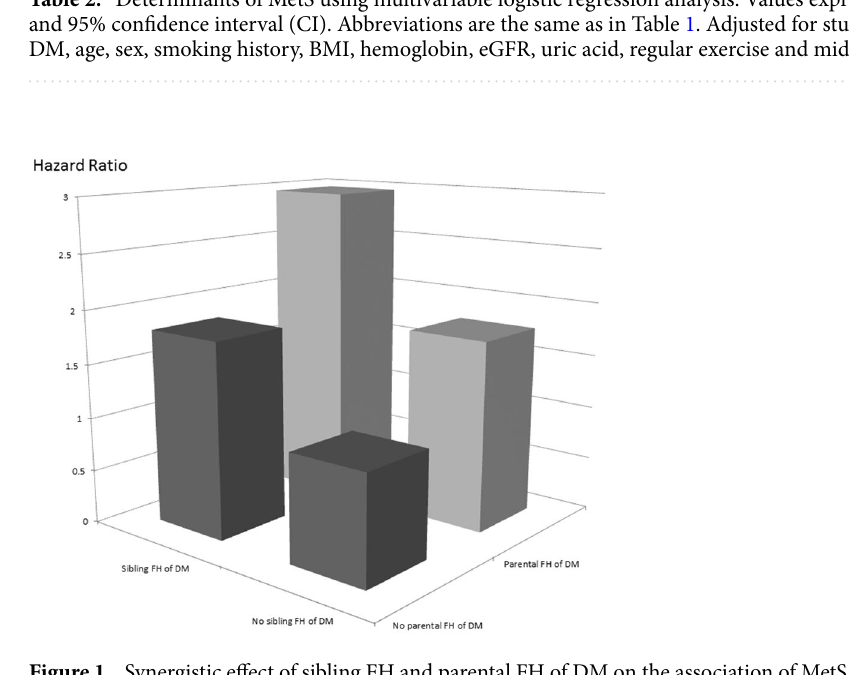
Figure 1. Synergistic effect of sibling FH and parental FH of DM on the association of